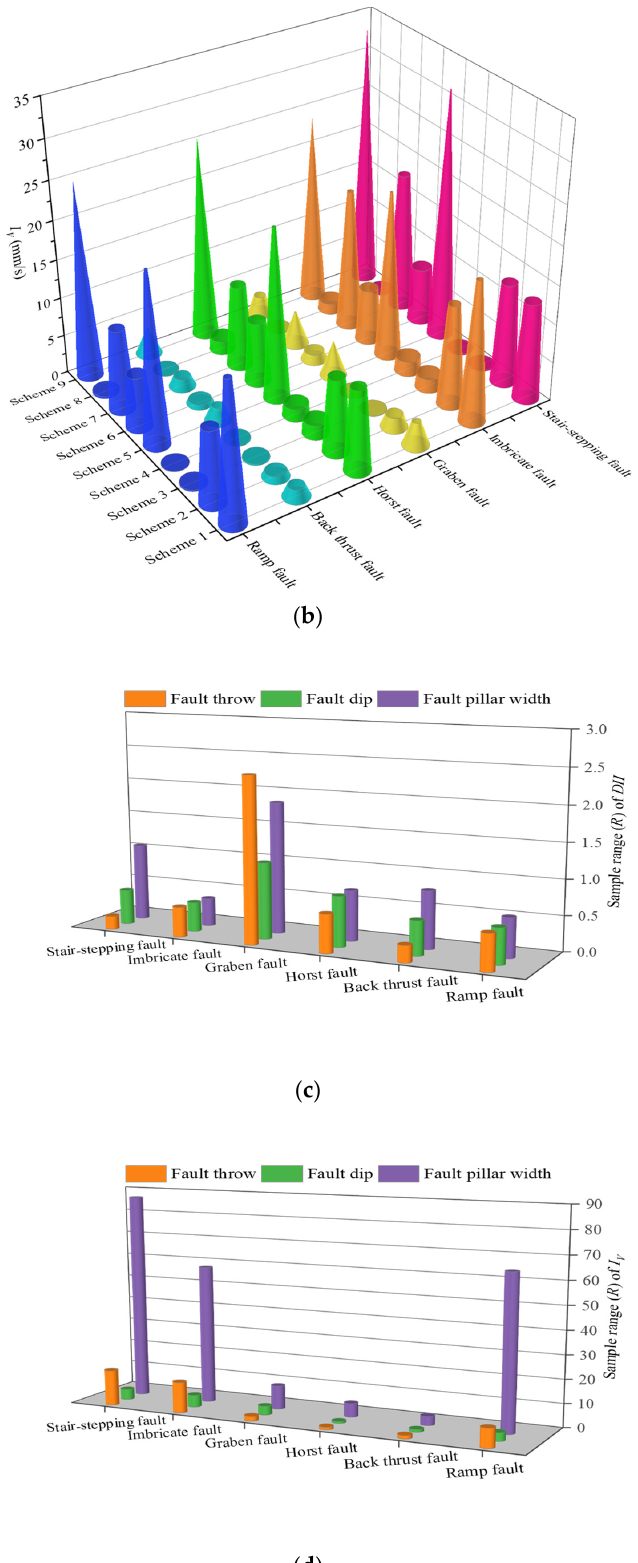
Figure 12. Orthogonal experimental results. ( a , b ) represent DII and I V distribution of different orthogonal experimental schemes, respectively. ( c , d ) represent the sample range of DII and I V correspond to different orthogonal experimental schemes